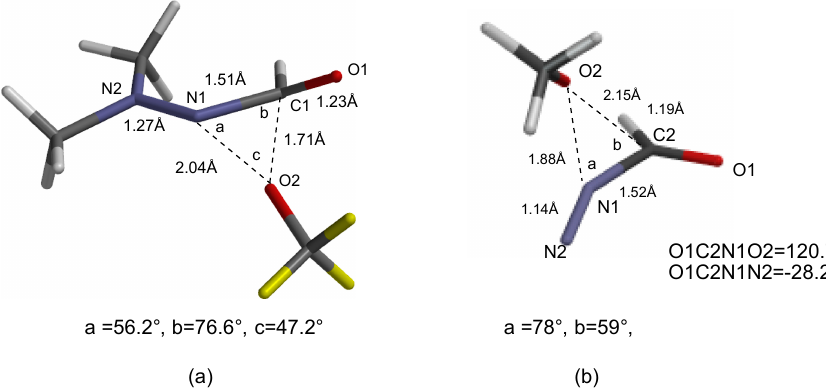
Figure 13. Twisted HERON transition states of ( a ) N -methoxy- N -dimethylaminoformamide 17e and ( b ) 1-formyl-1-methoxydiazene 44 (R 1 = H, R 2 = Me) at B3LYP/6-31G(d) level [53,76]. Analysis of charge separation in the B3LYP/6-31G(d) transition state revealed a partial positive